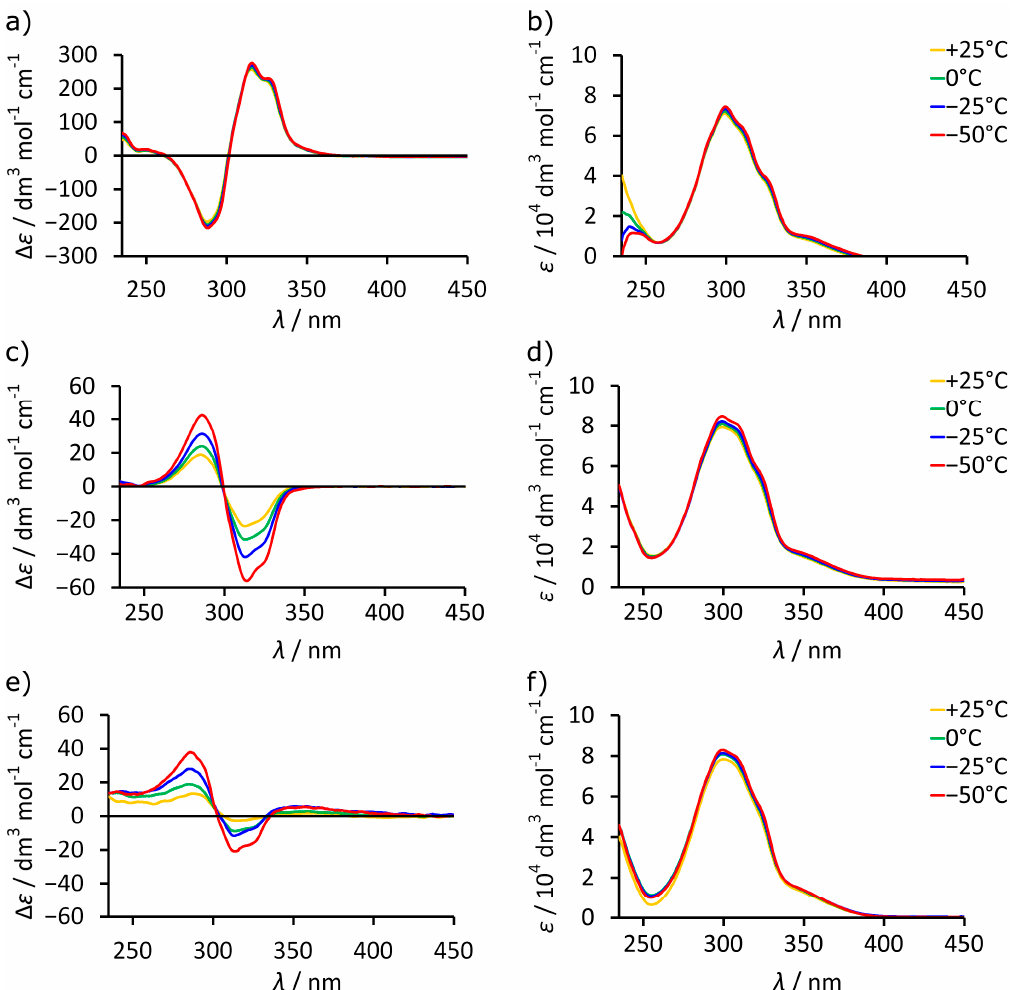
Figure 2. Temperature-dependent ECD and UV spectra in various solvents: ( a ) ECD spectra of L - 1 in CHCl 3 ; ( b ) UV spectra of L - 1 in CHCl 3 ; ( c ) ECD spectra of L - 1 in MeOH; ( d ) UV spectra of L - 1 in MeOH; ( e ) ECD spectra of L - 2 in MeOH; ( f ) UV spectra of L - 2 in MeOH (all intensities of ECD and UV spectra calculated for the concentration of the cavitand).